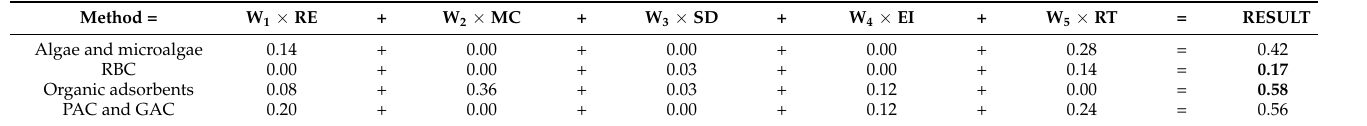
Table 3. Weighted linear sum of the methods